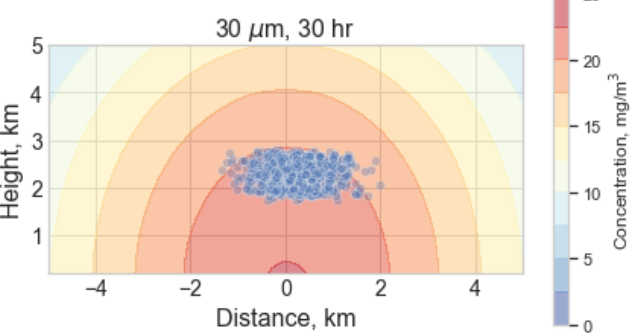
Figure 5. Crosswind section through volcanic ash transport and dispersal (VATD) Ash3D (color contours) and Lagrangian model (separate particles) output for test case (Table 4). Instantaneous source and no wind shear, showing advection, settling and dispersal of 30 µ m ash after 30 h. Note in the Lagrangian layered model, particles are concentrated in lower, high-turbulence